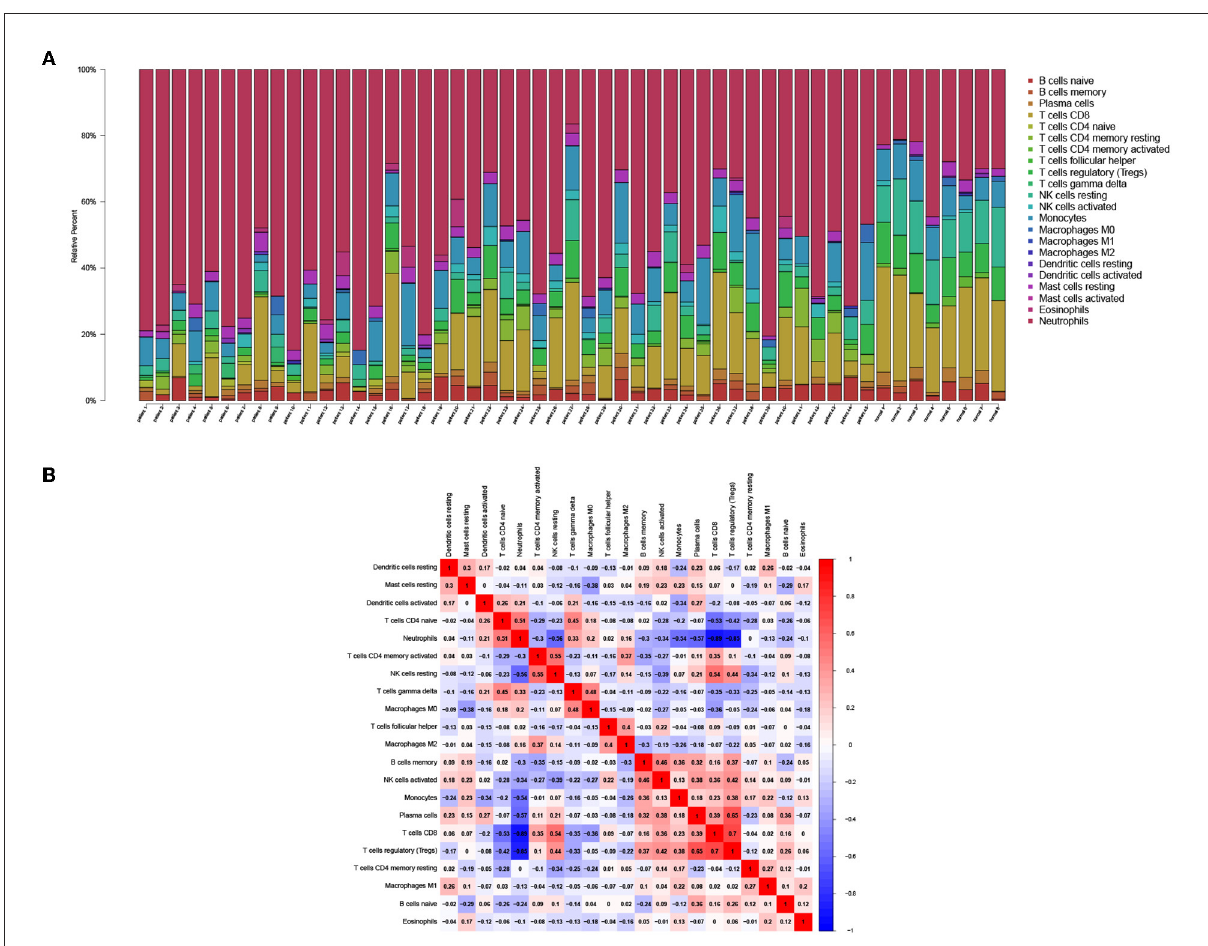
FIGURE5 Immune infiltration analysis of DEGs from high throughput sequencing dataset. (A) Bar charts showing the proportions of immune cell subsets. (B) Correlation heatmap showing the association of various immune cell subsets.